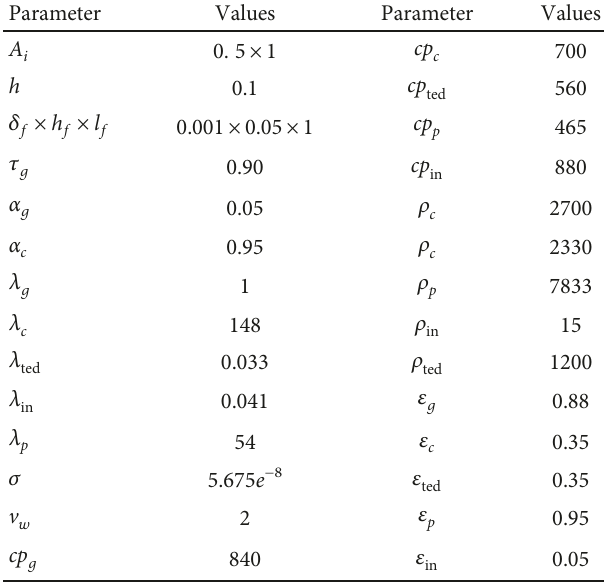
Table 1: Input parameters for numerical calculations. Parameter